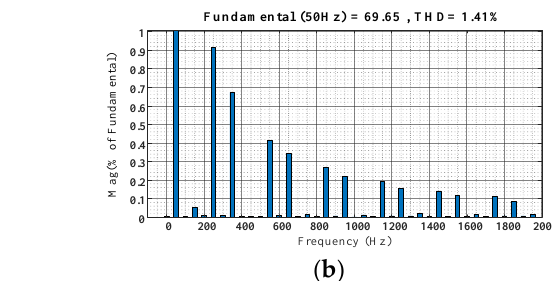
Figure 14. Mode 1 harmonic analysis diagram. ( a ) Harmonic analysis diagram before harmonic